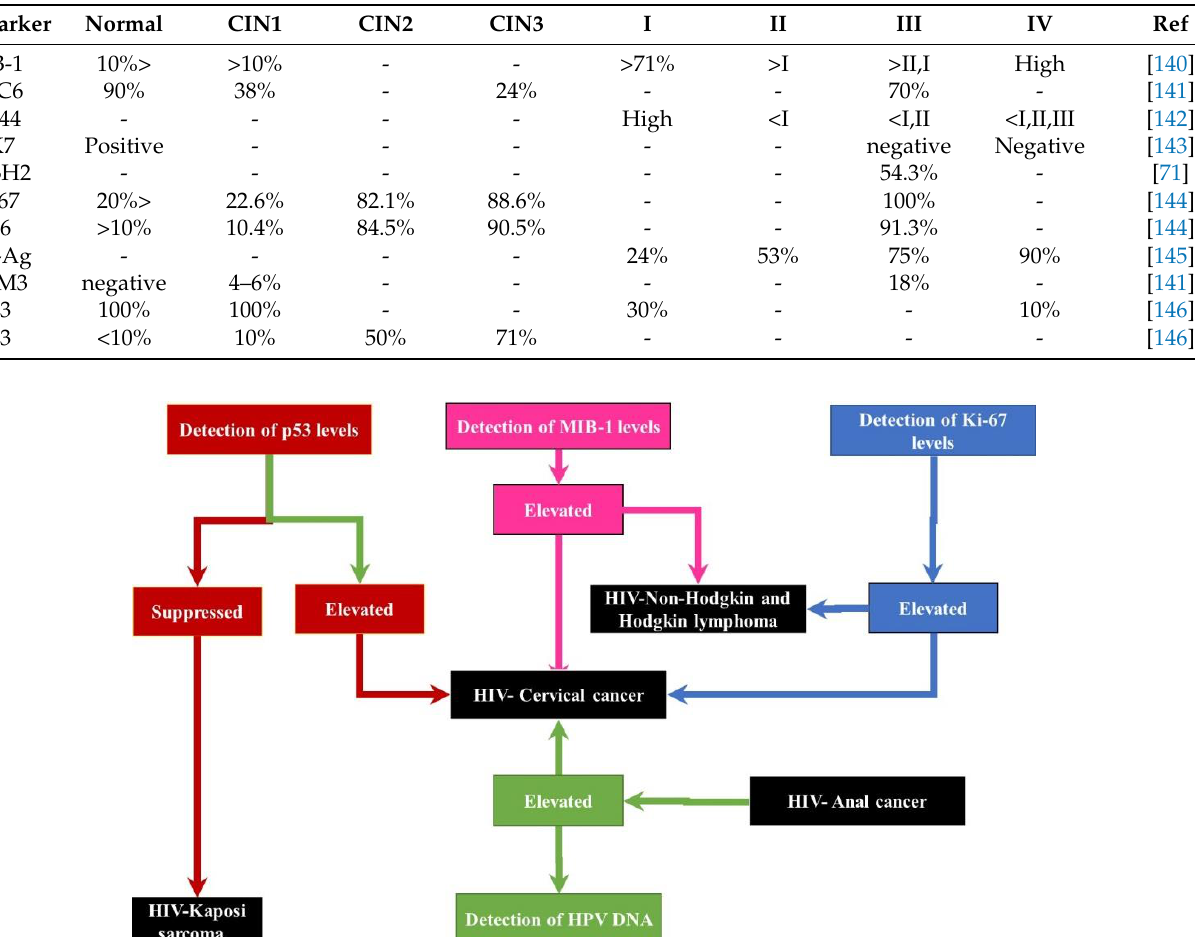
Table 4. Biomarkers used to diagnose different stages of cancers (Cervical cancer).